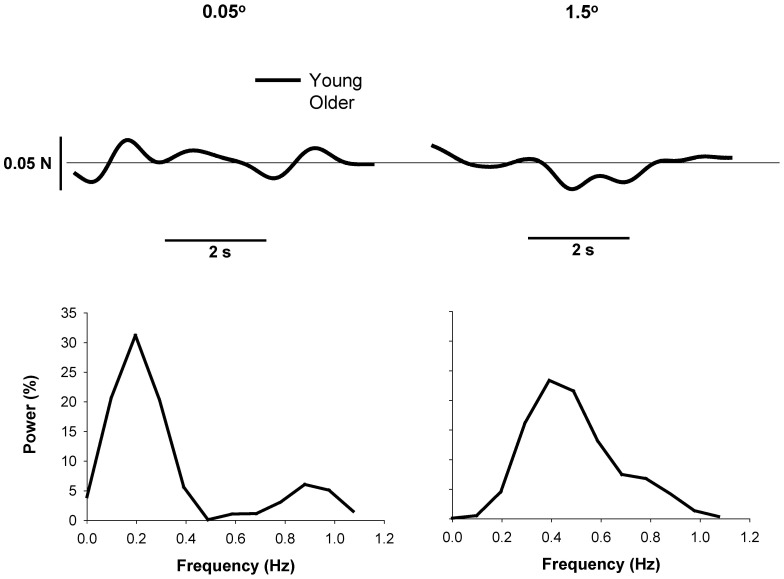
Modulation of power below 1 Hz for young and older adults with magnification of visual feedback.The top row shows a representative force output low-passed at 1 Hz for a young and an older adult during the lowest (0.05°) and highest (1.5°) visual angle. The bottom row demonstrates the power spectrum of force from 0–1 Hz for the same subjects. Age-associated differences in the modulation of force oscillations below 1 Hz are evident.